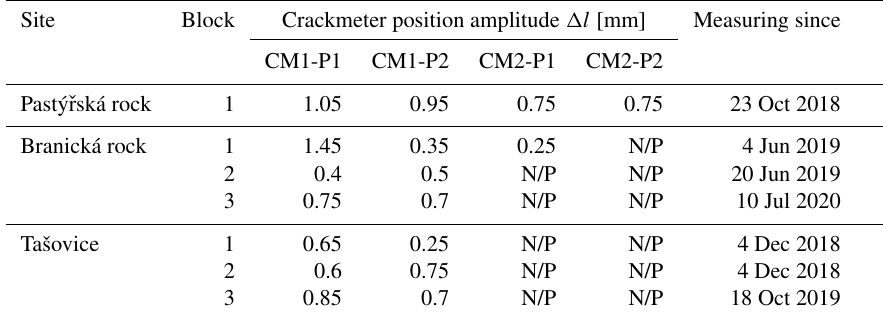
Table 4. Amplitude of crackmeters measuring at Pastýˇrská rock: one block, four crackmeters; Branická rock: three blocks, seven crackmeters; and Tašovice: three blocks, six crackmeters. The table shows the difference between the maximum and minimum opening of all the placed crackmeters. CM: crackmeter, P: position. The amplitude is calculated as the difference between the maximum and minimum position. “Block” refers to which specific block (according to Fig. 3) is instrumented by a crackmeter at each site. Last measured data: 27 January 2021.